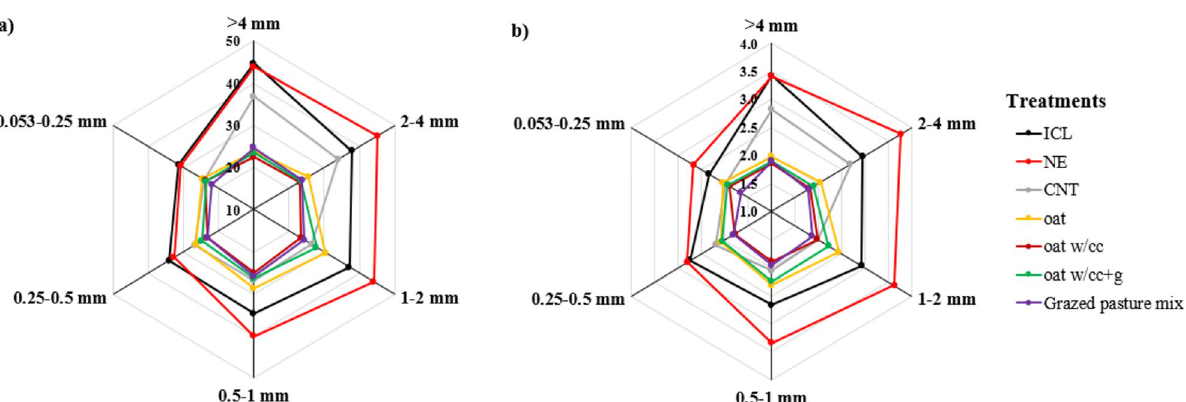
Figure 3. Radar graph depicting the ( a ) aggregate-associated C (g kg −1 aggregate) and ( b ) aggregate-associated N (g kg −1 aggregate) under different production systems. ICL integrated crop–livestock, NE natural ecosystem, CNT control, CC cover crop, g